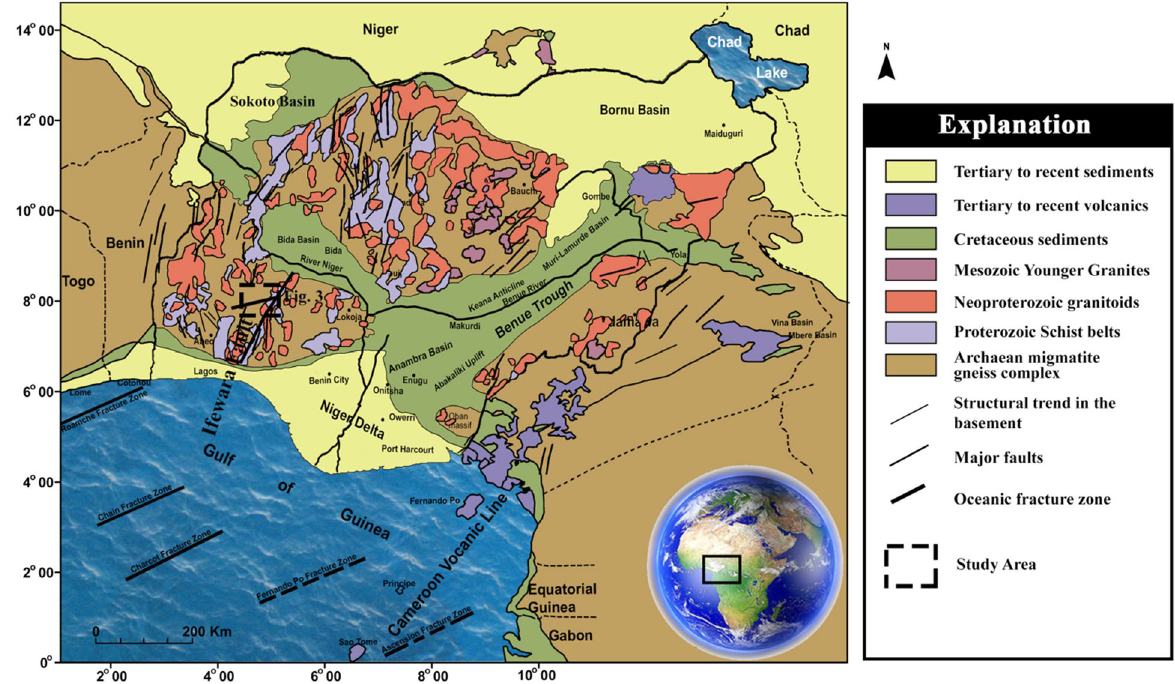
Figure 1. Simplified geological map of Nigeria and environ showing the study area indicated with dashed black lines (Modified after Ref. 13 ).